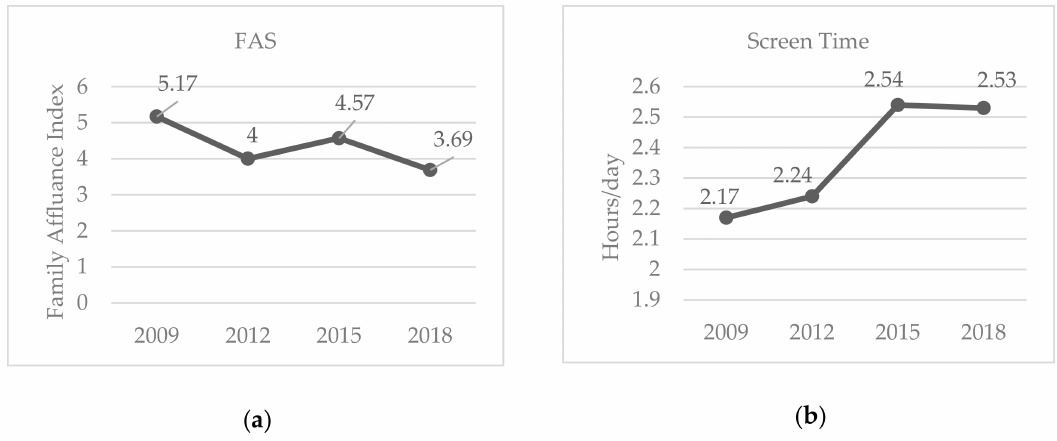
Figure 2. Mean FAS and ST scores among Greek preschool children between 2009 and 2018: ( a ) mean FAS scores for Greek preschool children between 2009 and 2018; ( b ) mean ST scores among Greek preschool children between 2009 and